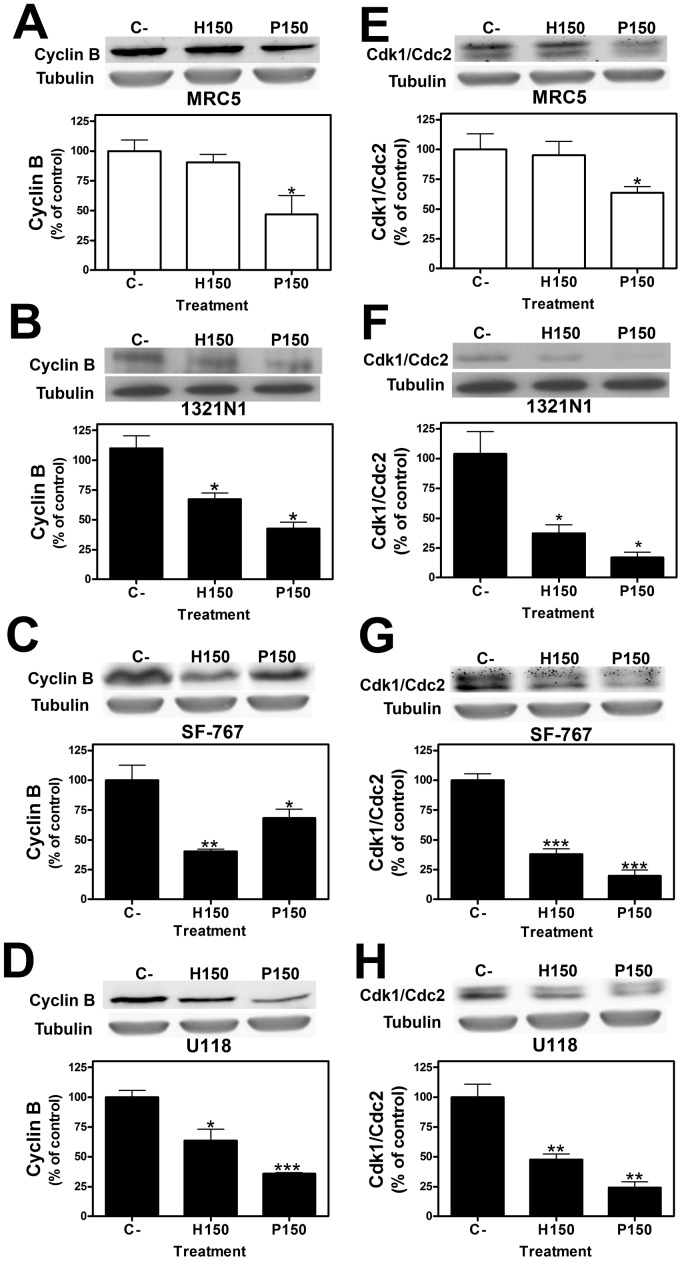
2OHOA inhibition of Cyclin B and Cdk1/Cdc2 proteins in 1321N1, SF-767 and U118 human glioma cells but not in non cancer MRC-5 cells.Cyclin B and Cdk1/Cdc2 proteins in 1321N1, SF-767 and U118 human glioma cells and MRC-5 non cancer cells. A, B, C and D present in the upper panels: a representative immunoblot showing cyclin B expression after exposure to 2OHOA (H) or palmitate (P: 150 µM; 24 hours). Lower panels: Bar diagram showing the mean±SEM values of cyclin B expression in (A) MRC-5, (B) 1321N1, (C) SF-767 and (D) U118 cells, upon exposure to 2OHOA (H) or palmitate (P: 150 µM; 24 h) when compared with untreated controls (C). E, F, G and H show a representative immunoblot of Cdk1/Cdc2 expression after exposure to 2OHOA (H) or palmitate (P: 150 µM; 48 hours, upper panels). The lower panels show the bar diagram showing the mean±SEM values of Cdk1/Cdc2 expression in (E) MRC-5, (F) 1321N1, (G) SF-767 and (H) U118 cells after exposure to 2OHOA (H) or palmitate (P: 150 µM; 48 h) when compared with untreated controls (C). (*p<0.05, **p<0.01, ***p<0.001; n = 6).